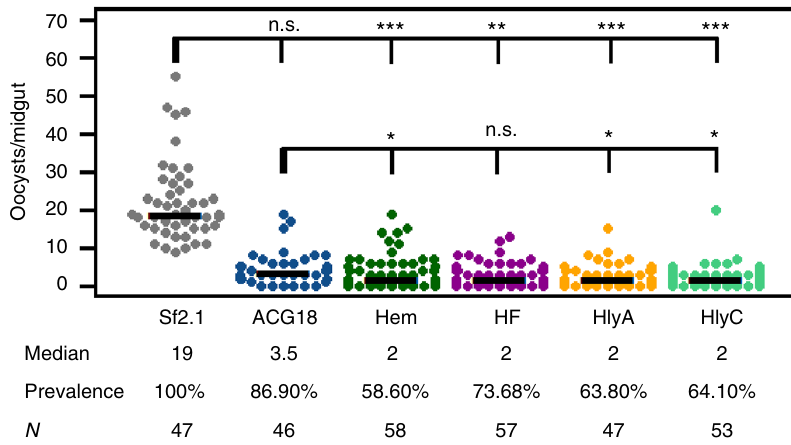
Fig. 6 BMI strains signi fi cantly reduce the prevalence of Plasmodium infection in mosquito midguts compared to the constitutively expressing strain. In three separate trials, oocysts were counted in mosquitoes infected with Asaia strains that were fed on a P. berghei infected mouse. Each dot represents an individual midgut and the number of P. berghei oocysts it contained. Prevalence is the fraction of midguts with at least one oocyst. SF2.1 is the wild type Asaia strain (negative control) and ACG18 is the constitutively-expressing positive control. All strains secreting scorpine signi fi cantly reduced the median number of oocysts (horizontal bars) compared to the wild type strain (quantile regression, P «0.001). There was no signi fi cant difference in median oocyst number between the constitutive paratransgenic strain (ACG18) and any of the BMI strains (quantile regression, P > 0.05). The prevalence of infection (horizontal comparisons in the fi gure) was not signi fi cantly different between the wild-type and the positive constitutive control, while all of the BMI strains were signi fi cantly different ( χ 2 , 1 df). All of the BMI strains except ACG18.HF showed a signi fi cant decrease in prevalence compared to the constitutive positive control ACG18 ( χ 2 , 1 df). P -values: * P < 0.05, ** P < 0.01, *** P <